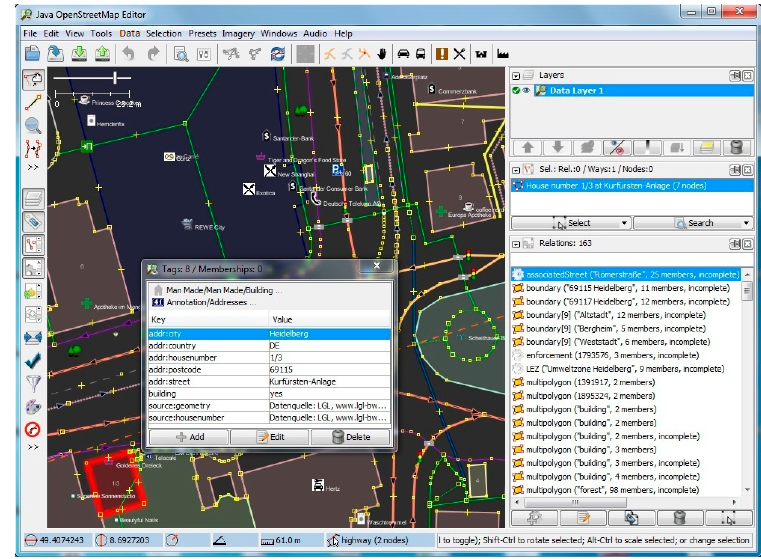
Figure 8. Relational properties of a sample random building.